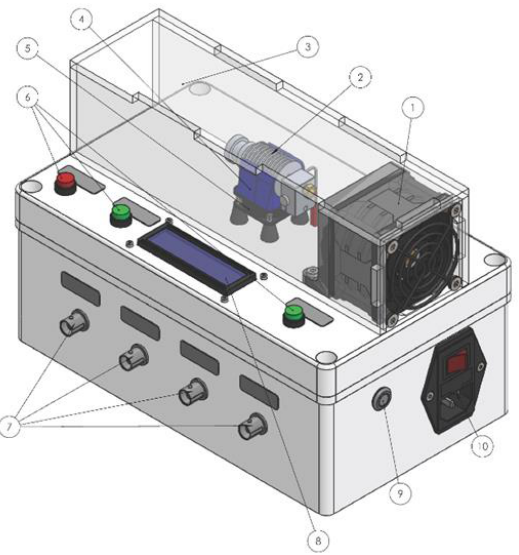
Figure 1. 3D-model layout of the Deusto Heater Experimental Setup. Table 1. Deusto Heater Experimental Setup — List of the main external components of the prototype.